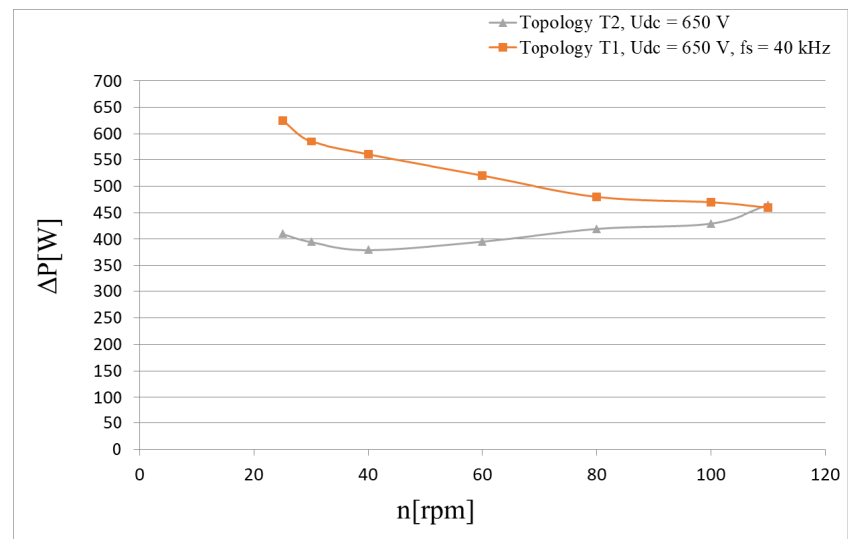
Figure 9. Power losses in the T1 and T2 topologies at U dc = 650 V.